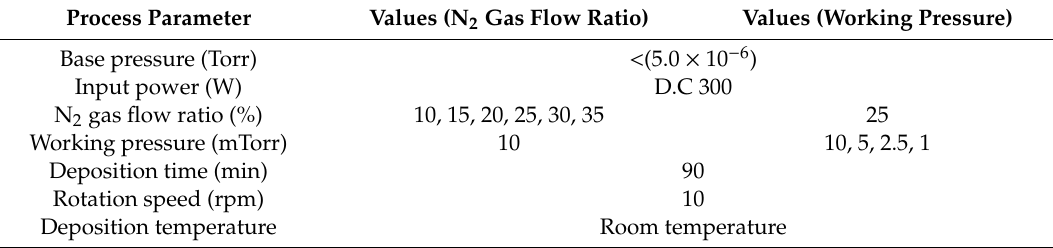
Table 1. Deposition conditions of the Mo–Si–N